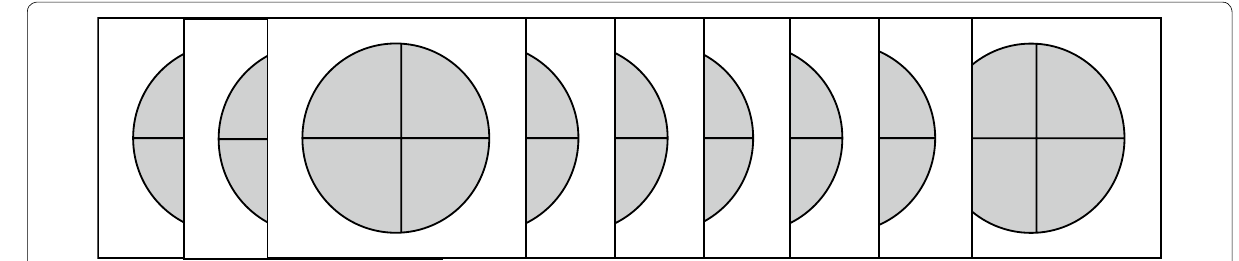
Fig. 1 Learning phase: “standard” stimulus (700 ms) was presented 10 times in succession represented by a shape